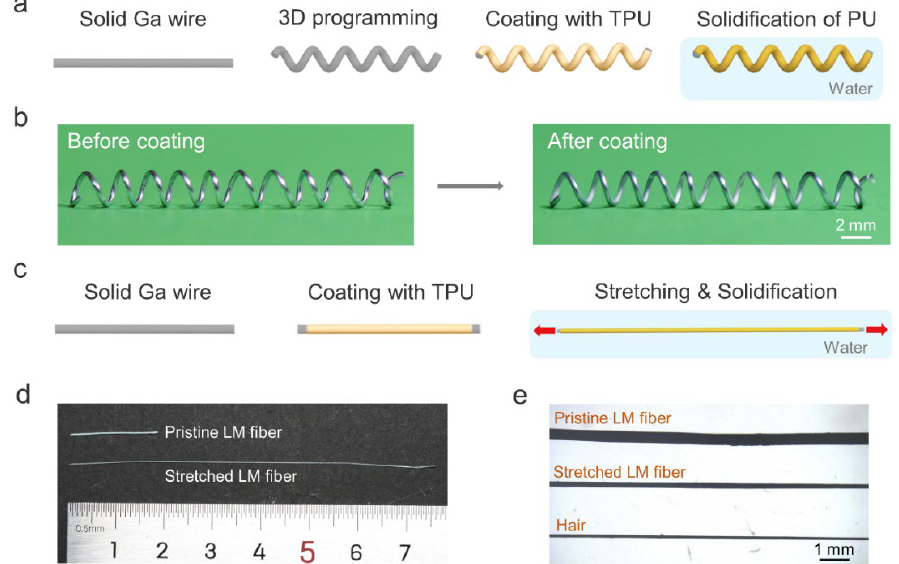
Figure 1. Shape-programmable LM fibers. ( a ) Schematic illustration of the preparation of 3D helical LM–PU fibers. ( b ) Photographs of the LM before and after coating with PU. ( c ) Schematic illustration of the reduction of the fiber diameter during PU solidification. ( d ) Comparison of the LM fiber before and after stretching. ( e ) Optical microscope photographs of LM fibers and human hair.